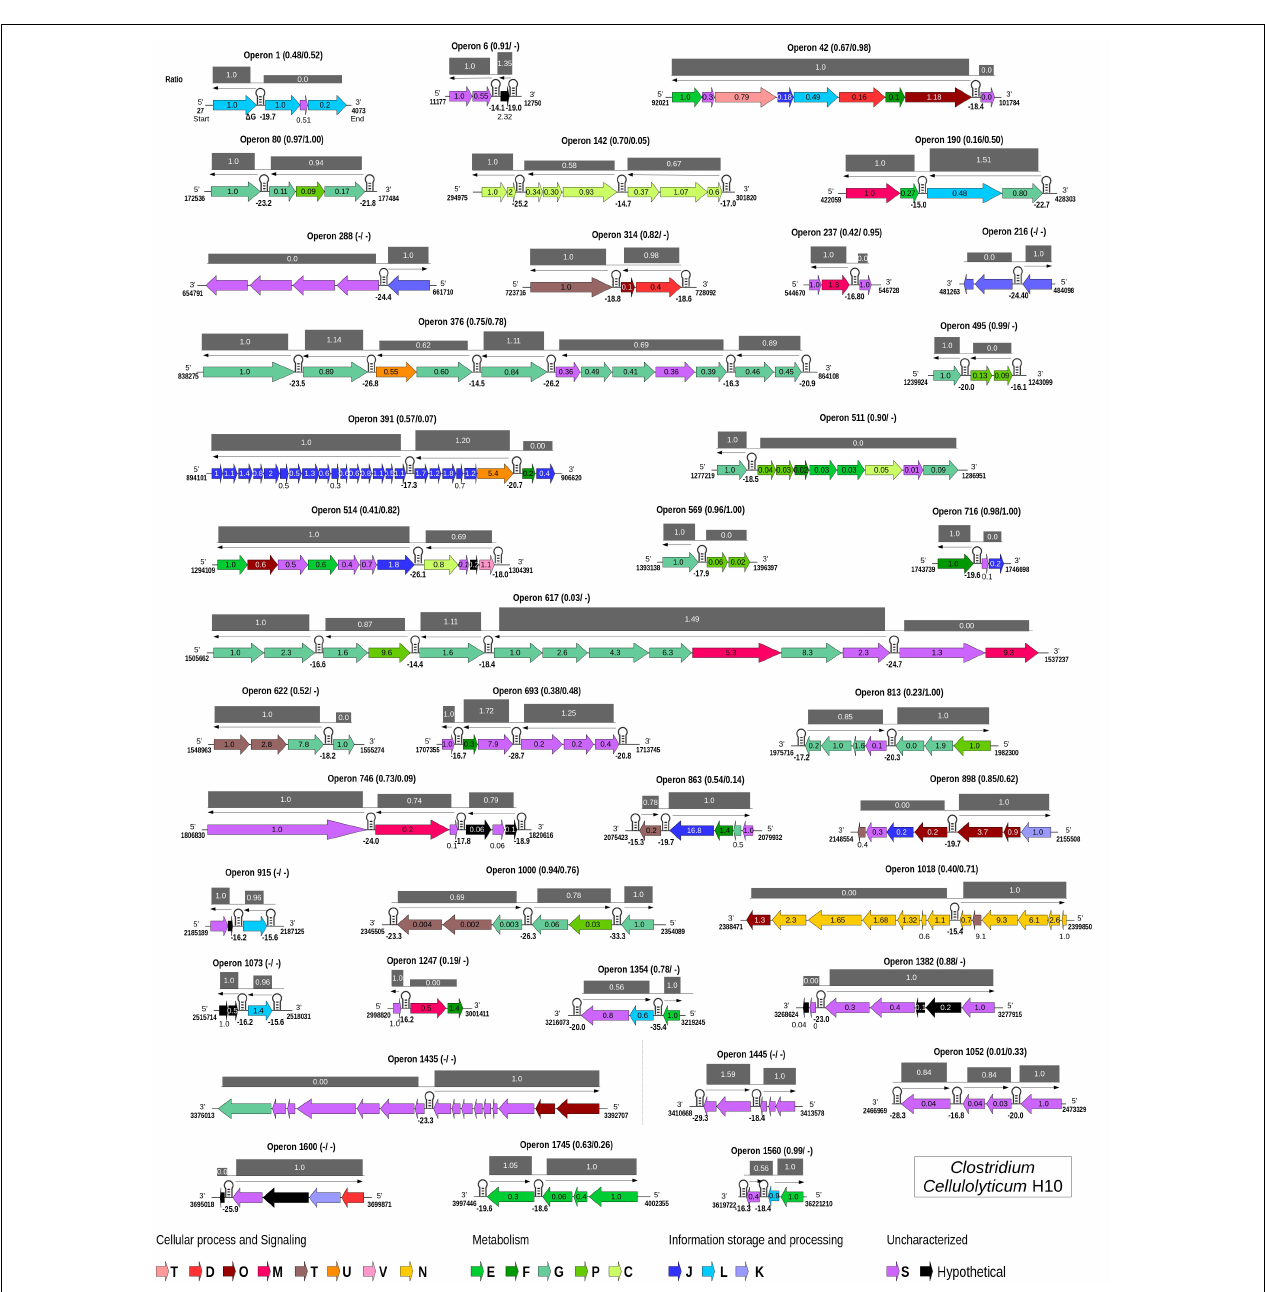
FIGURE 4 | Genome-wide maps of selective RNA processing and stabilization (SRPS) operons and their predicted stoichiometry for Clostridium cellulolyticum . For each predicted polycistronic SRPS operons, the number of genes, the harbored stem–loops (SLs), mRNA-Seq-based transcript ratio ( inside the genes ), and the predicted ratio ( above the operons ) were shown. The single-line arrow above the genes shows the upstream control unit (UCU) of the SL; the (cid:49) G is represented under the SLs . Ratios are calculated using the (cid:49) G of SLs, such that in an operon, the (cid:49) G of all the harbored SLs were divided by the (cid:49) G of the first SL from the 5 (cid:48) -UTR of the operon. Genes in the operons are colored based on COGs (mapped using the eggNOG database) (Huerta-Cepas et al., 2017). Pearson’s correlation coefficients between the predicted ratio and the experimentally determined transcript abundance (TA) and protein abundance (PA) are represented as (TA/PA) beside the operon number ; a dash indicates that the data is not